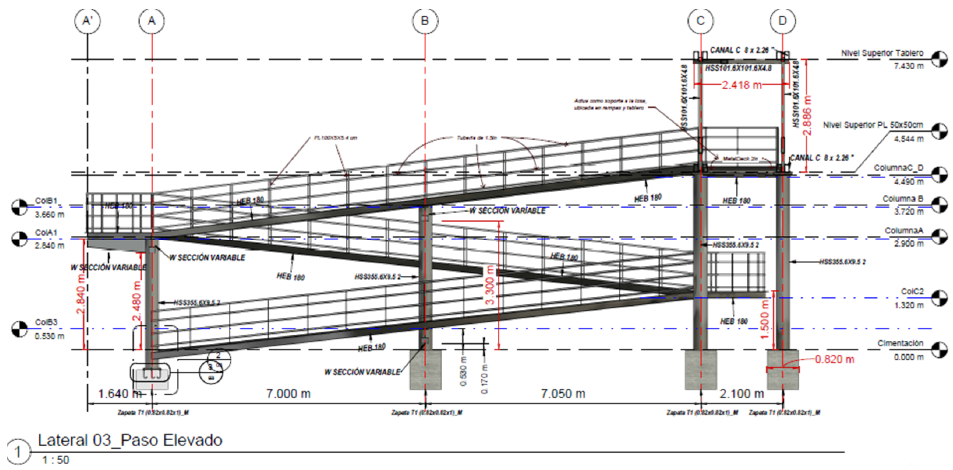
Figure 6. Elevation view of the design of the pedestrian bridges under study (schematic view).